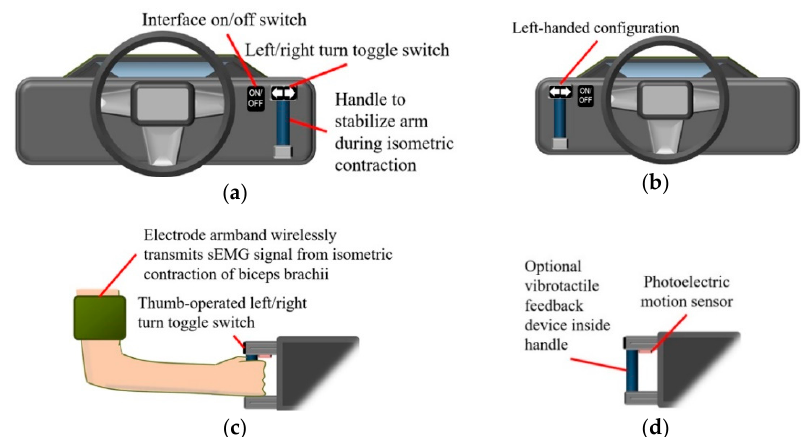
Figure 2. Steering assistance interface for ( a ) right-handed operation and ( b ) left-handed operation. ( c ) Steering direction selected with toggle switch before steering is initiated by surface electromyography (sEMG) signals from isometric contraction of biceps brachii. ( d ) Holding handle causes photoelectric motion sensor to activate reception of sEMG signals by steering assistance system, whereas releasing handle deactivates signal reception.